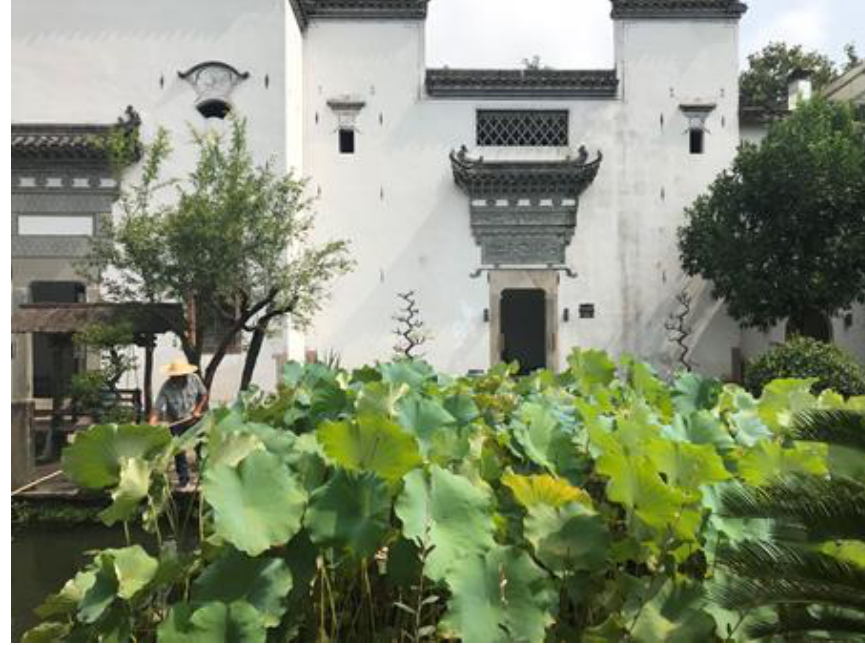
Figure 1. The project of protection and utilization of ancient folk houses. Source: the authors.